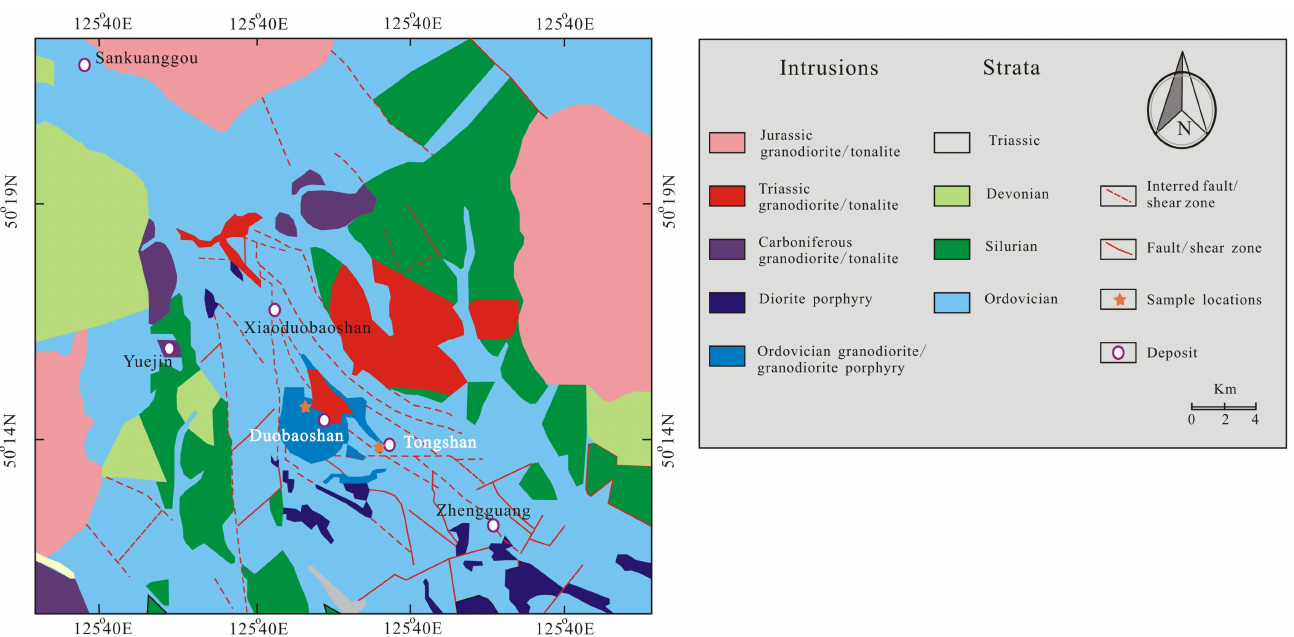
Figure 2. Simplified geological map of the DBS ore field (modified after [23,25]). The DBS-TS deposit, with proved reserves of 4.4 Mt Cu and 0.15 Mt Mo, is the third largest porphyry Cu-(Mo) deposit in the eastern part of CAOB after the Oyu Tolgoi and Erdenet (>11 Mt Cu; [61]) deposits. The deposit is hosted by the early Ordovician por- phyritic diorite or granodiorite (Figure 2). U-Pb zircon age for the DBS hosting granodioritic porphyries is 477~482 Ma [23] and 475.9 ± 0.8 Ma [11] for the TS hosting granodiorite. The Re-Os isochron age of molybdenite grains for the DBS deposit is 475.9 ± 7.9 Ma by